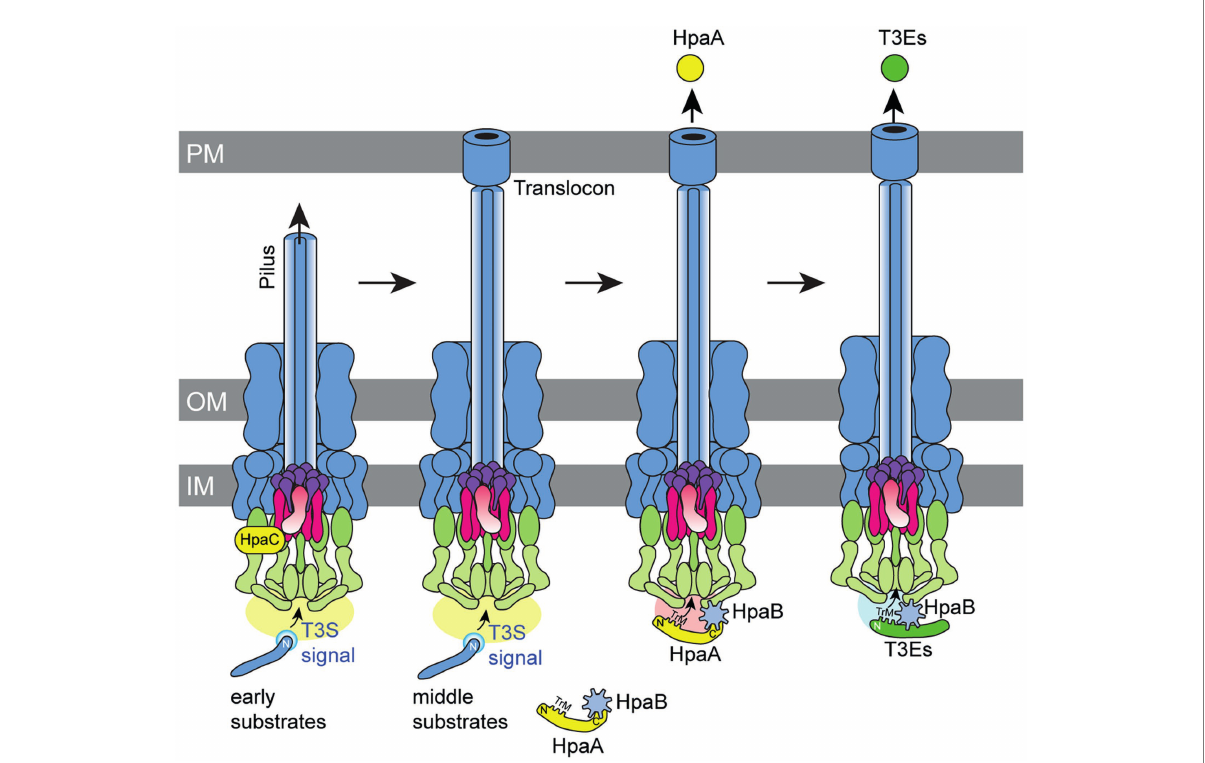
FIGURE 8 Model of the interplay between HpaA and HpaB during T3S in X. euvesicatoria . The T3S system assembles in both bacterial membranes and contains ring structures in the outer membrane (OM) and inner membrane (IM). The IM rings surround the export apparatus (shown in purple) and are connected to the cytoplasmic sorting platform (shown in green). The assembly and activation of the T3S system leads to the secretion of early substrates (i.e., the predicted inner rod protein HrpB2) and allows formation of the extracellular pilus. A switch in T3S substrate specificity induced by the T3S4 protein HpaC presumably involves a conformational change in the cytoplasmic domain of the export apparatus component HrcU (shown in pink) and activates the secretion of middle substrates such as components of the translocon in the plant plasma membrane (PM). The T3S chaperone HpaB is inactivated during assembly of the pilus and the translocon by the interaction with HpaA. A second predicted switch in T3S substrate specificity activates translocation of HpaA, which requires the N-terminal TrM for efficient export. Translocation of HpaA depends on HpaB, which binds to components of the T3S system and allows the specific recognition of the TrM, independently of its interaction with the C-terminal region of HpaA. Translocation of HpaA liberates HpaB and thus allows the translocation of T3Es, which also depend on the presence of a TrM for efficient recognition by the T3S